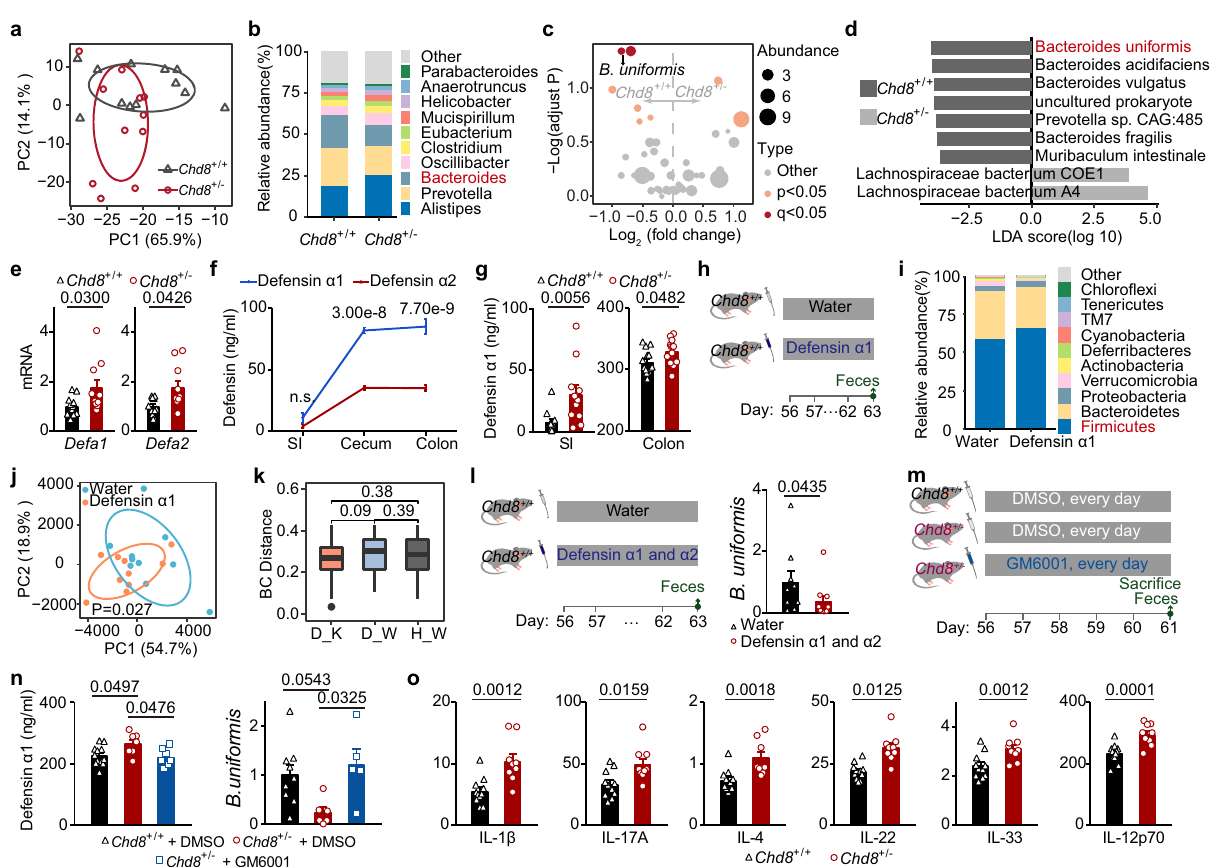
Fig. 3 Increased levels of alpha defensins contribute to gut microbiota dysbiosis in the Chd8 + / − mice. a – d Metagenomic sequencing of the gut microbiota from 8-week-old mice. n = 12 and 11 mice, respectively. a PCA plots (species, Total Sum Scaling-Transformed). b Microbiota composition (genus). c Volcano plots. d LDA plots. e qPCR analysis in the small intestine of 12-week-old mice. n = 12 and 10 mice, respectively. f ELISA of proteins in the small intestinal, cecal, and colonic contents of 12-week-old Chd8 + / + mice ( n = 5). g ELISA of defensin α 1 in the small intestinal (SI) and colonic contents (Colon) of 12-week-old mice. n = 12, 11, 14, and 13 mice, respectively. h Schematic diagram for the defensin α 1 gavage. i – k A 16S rRNA sequencing of gut microbiota from 63-day-old mice ( n = 10 mice). i Microbiota composition (phylum). j PCA plots (genus, Total Sum Scaling-Transformed) (ANOSIM test). k BC distance (Total Sum Scaling-Transformed) between D_W (defensin α 1-treated mice and Chd8 + / + mice), H_W (water-treated mice and Chd8 + / + mice), and D_K (defensin α 1-treated mice and Chd8 + / − mice). Box plots were based on 350 data points and showed center line as median, box limits as upper and lower quartiles, whiskers as 1.5 × interquartile range and dots as outliers. l Schematic diagram for the defensin α 1 and α 2 gavage, and qPCR analysis of B. uniformis in the feces. n = 9 and 10 mice, respectively. m Schematic diagram for the GM6001 administration. n ELISA of defensin α 1 in the cecal contents (left), and qPCR analysis of B. uniformis in the feces (right). n = 9, 6, 5, 12, 7, and 7 mice, respectively. o Multiplexed determination of cytokine levels from colon of 12-week-old mice (pg/mg protein). n = 11 and 10 mice, respectively. Source data are provided as a Source Data fi le. Ellipses in ( a and j ) were drawn around each group ’ s centroid (95%). Quantitative data are shown as the mean ± SEM. Statistical analysis was determined by the two- tailed Mann – Whitney test ( e , g , l , and o ), one-way ANOVA with two-tailed Tukey ’ s multiple comparison test ( n ), and two-way ANOVA with Turkey ’ s test for multiple comparisons ( f ). Signi fi cance was indicated by P